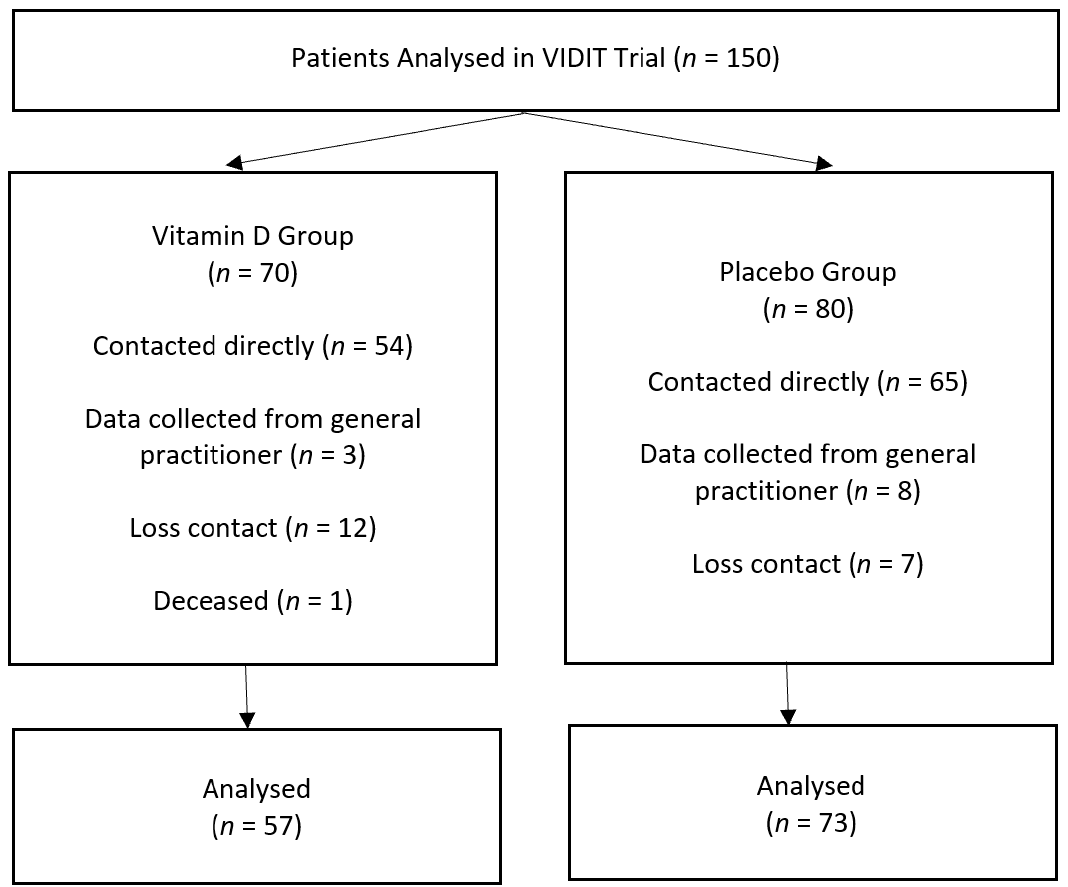
Figure 1. Patients excluded for analysis from original VIDIT trial.